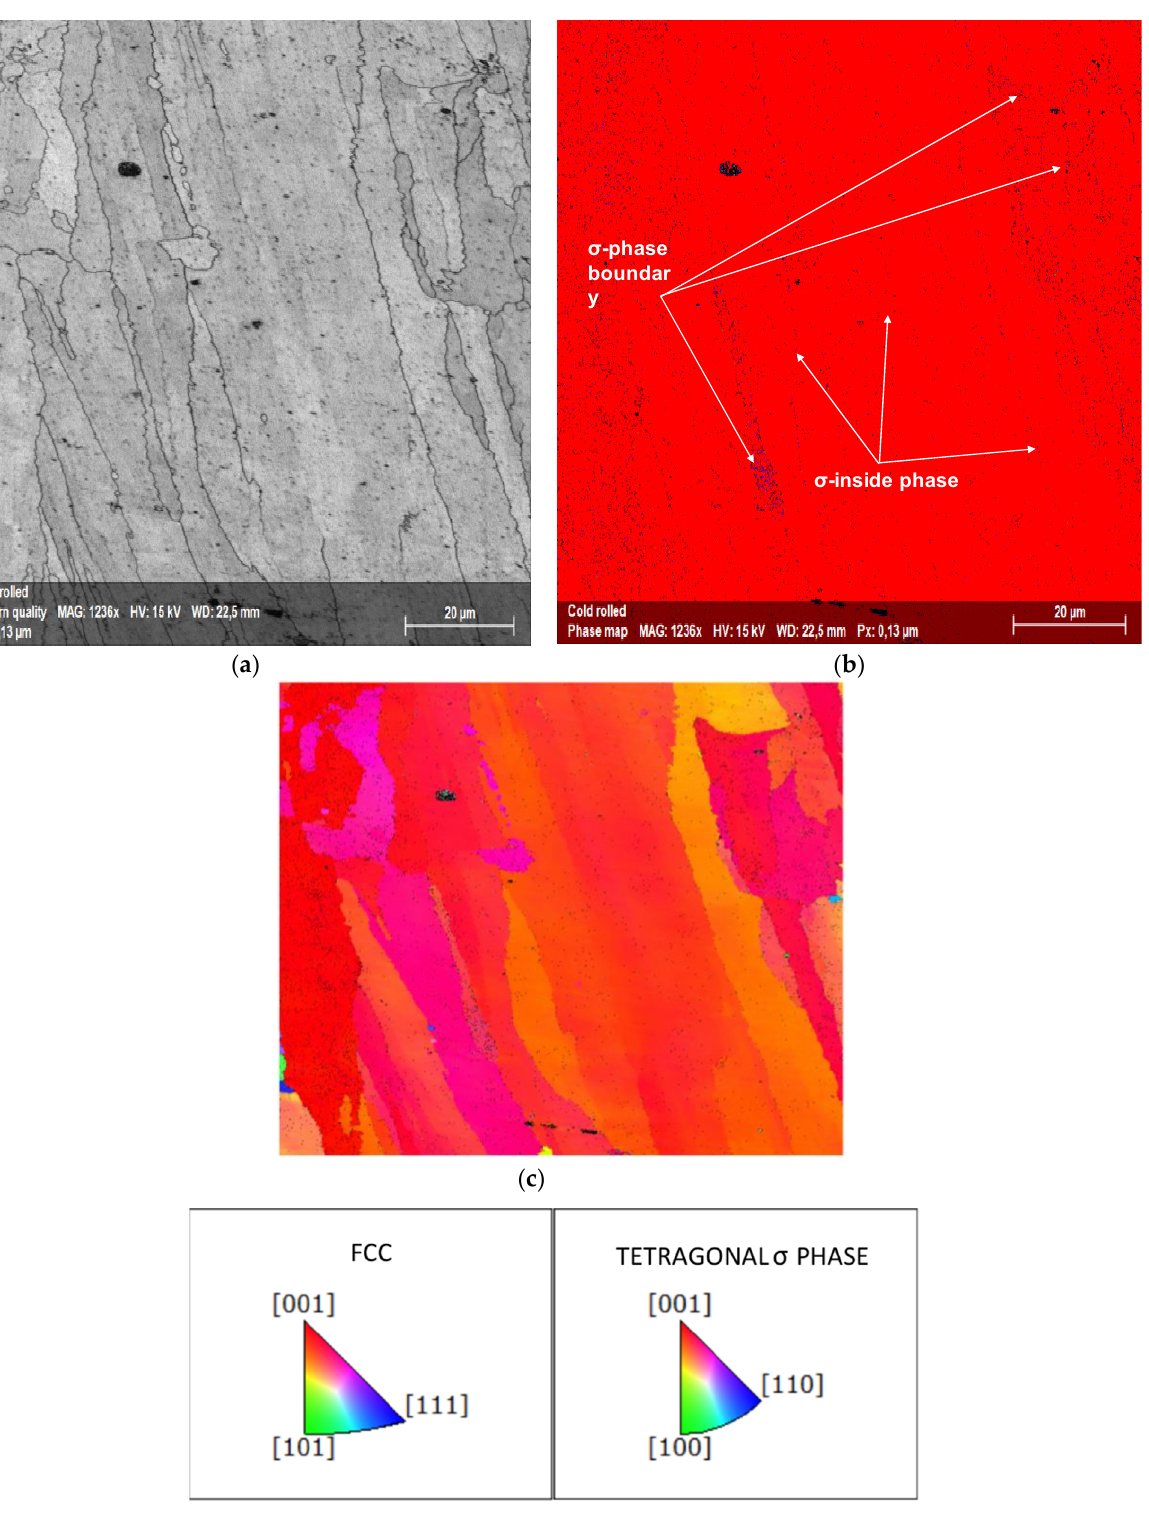
Figure 12. ( a ) Cross-sectional image of a cold-rolled sample. ( b ) corresponding EBSD map, with FCC matrix in red and σ phase precipitates in blue. ( c ) Inverse pole figure along Y direction, IPFY, of the same sample. ( d ) IPFY color scheme.